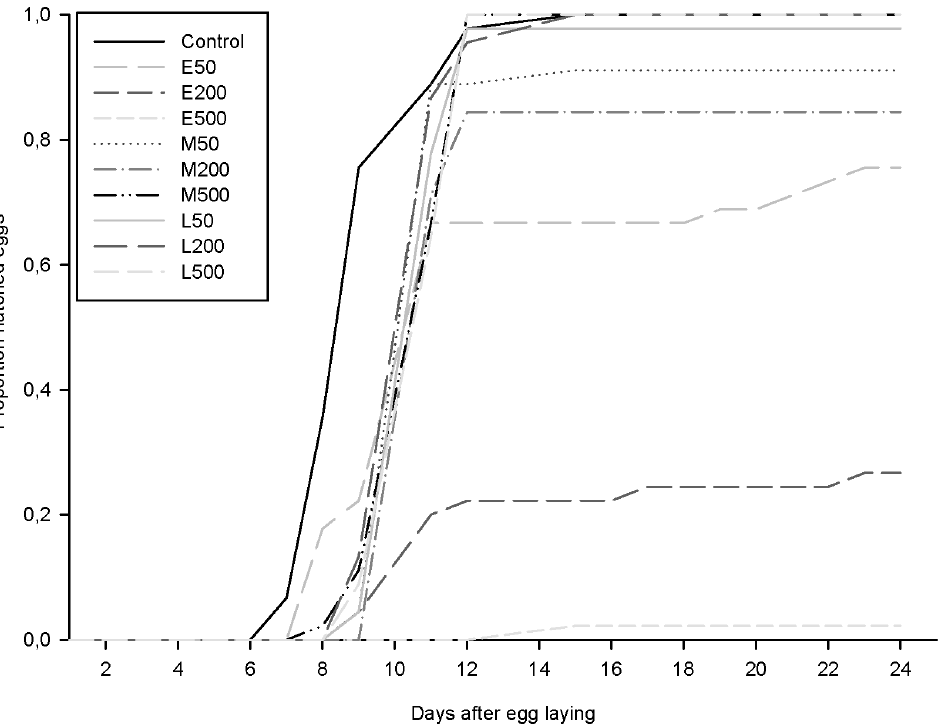
Figure 3. Proportion of hatched eggs as a function of time (days) after egg laying for different experimental groups, defined by developmental stage at irradiation and dose of gamma irradiation. Labels denote developmental stage (E=early, M=middle, L=late) and the dose level (50, 200, 500 Gy). Each line is based on the aggregate total of three replicates, i.e. representing 45 eggs.